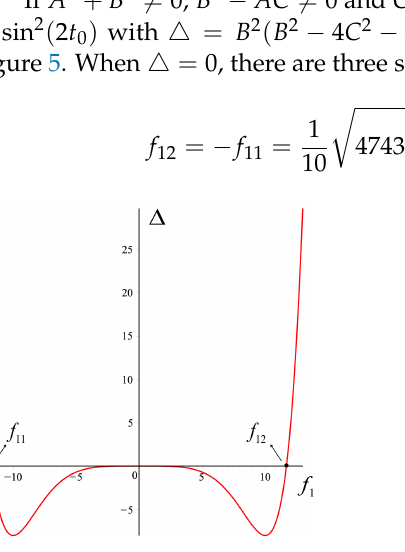
Figure 5. The image of function (cid:52) with respect to f 1 under condition UP